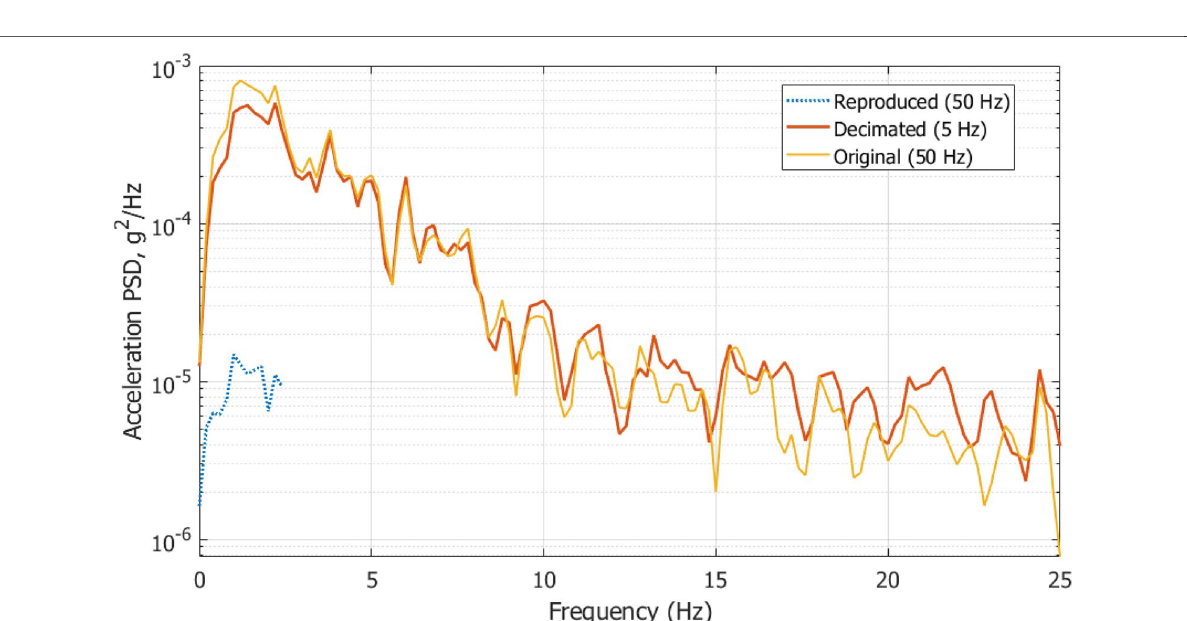
Fig. 13 PSD of original and reproduced El Centro earthquake ground